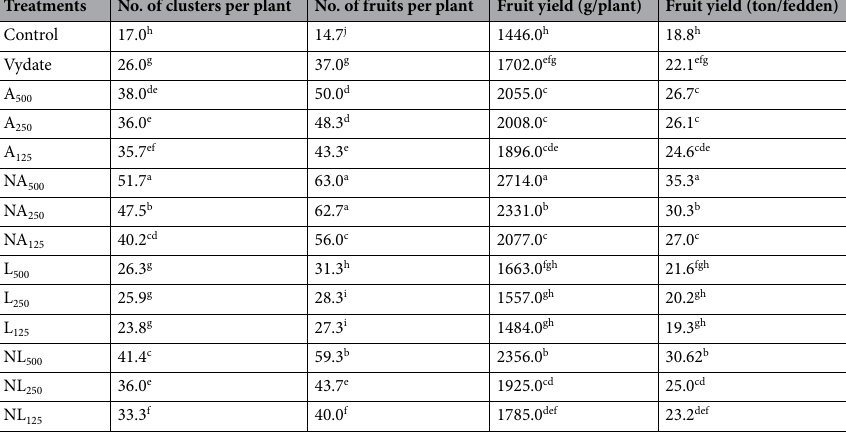
Table 4. Effect of A. annua and L. sativum extracts and their nano-formulations on flowering and fruit yield parameters of tomato plants. Means followed by the same letter(s) are not significantly (P < 0.05)